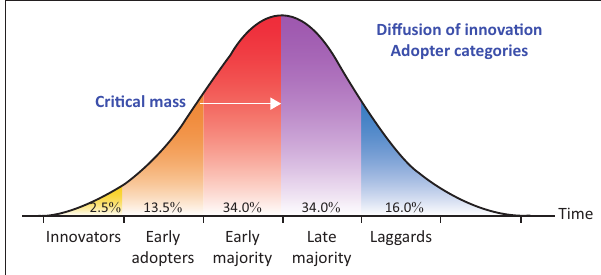
Innovators Early